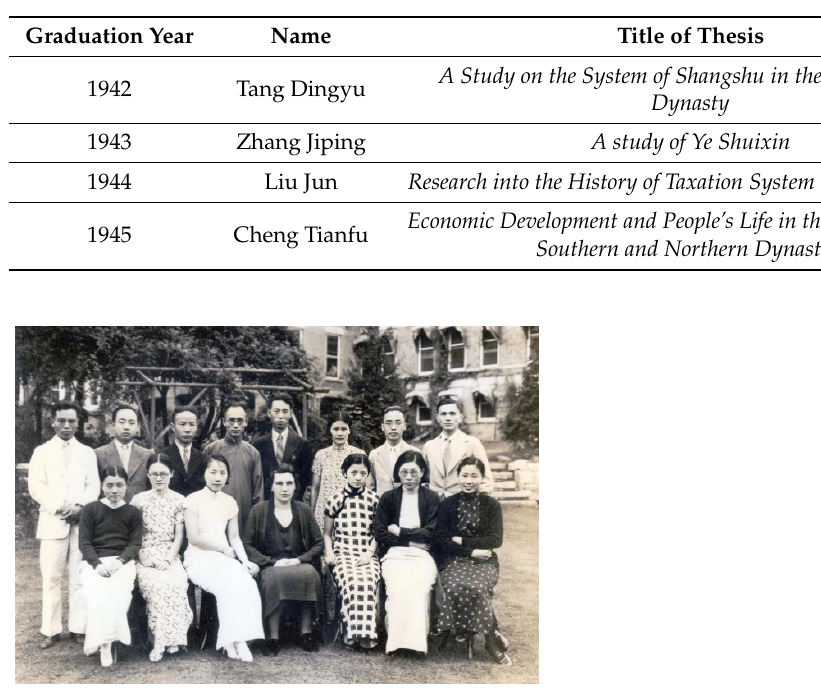
Table 1. The information of graduates.